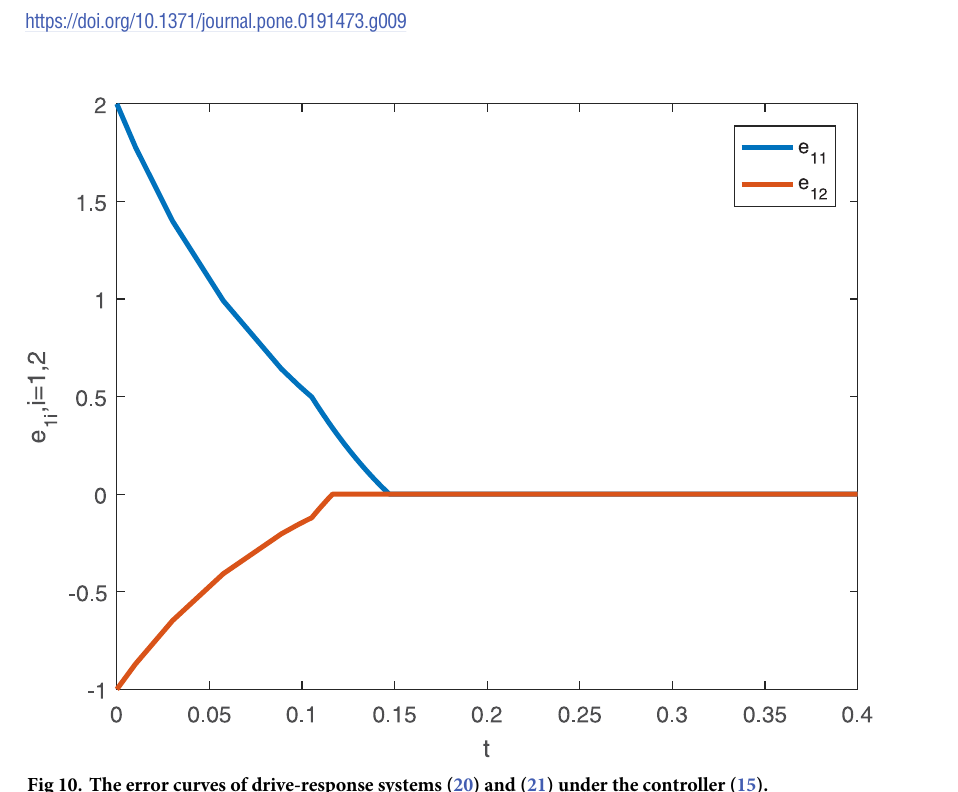
PLOS ONE | https://doi.org/10.1371/journal.pone.0191473 January 25,